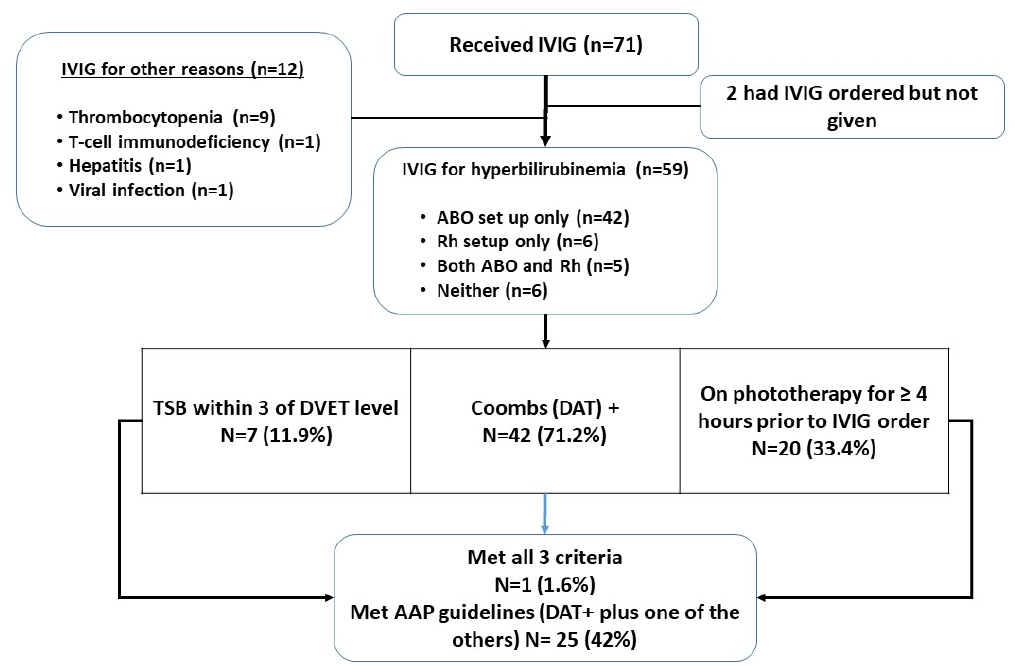
Figure 2. Patient flow diagram and assessment of meeting AAP Guideline criteria for IVIG treatment (abbreviations: DVET, double-volume exchange transfusion; DAT, direct antiglobulin test).